Question: What caption would you write for this figure?
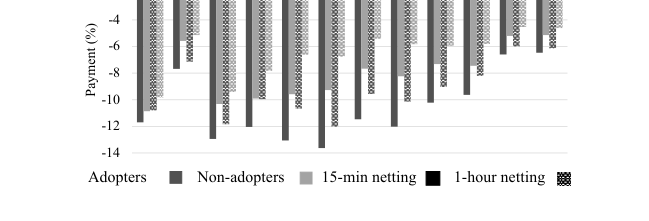
Answer: shows the surplus (top) and payment (bottom) gains (%) of DG adopters and non-adopters over their benchmark after joining community 1. Both classes beneﬁted from joining the community by having higher surpluses and lower pay- ments. However, adopters beneﬁted more from the community as they more often operate in net consumption zones different than the community. Congruent with Fig.3, households bene- ﬁted more from the community when the netting was faster.